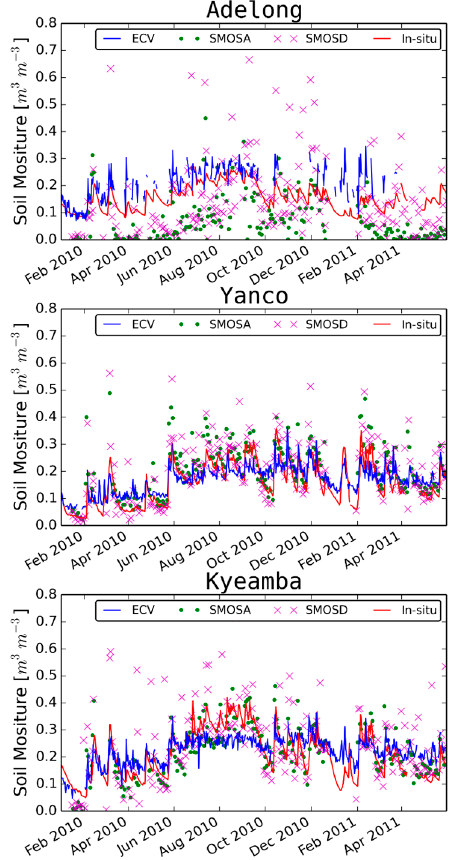
Figure 6. Comparison of temporal behavior of the soil moisture products in situ measurements of different network.